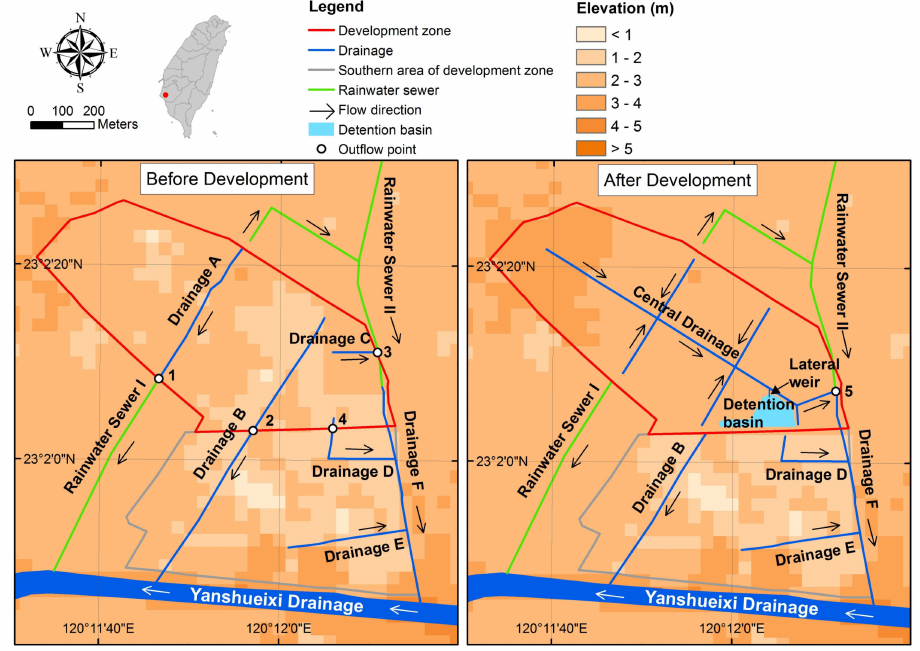
Figure 1. The maps of the study area before and after land